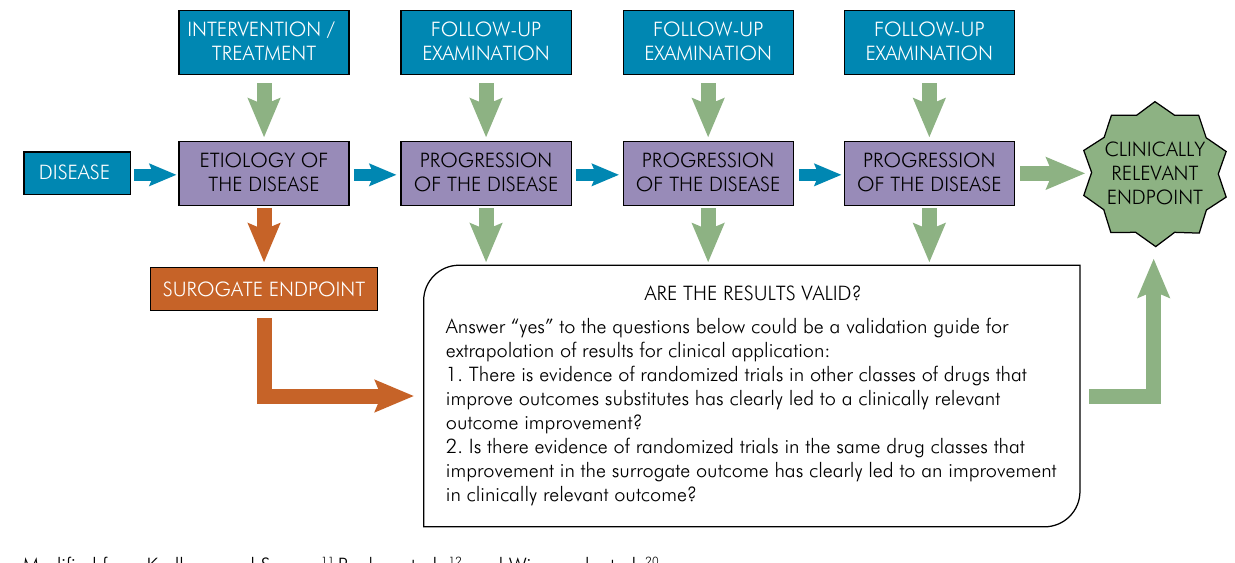
Figure. Proposal of a flow chart of actions for validation of surrogate endpoints for application in clinical